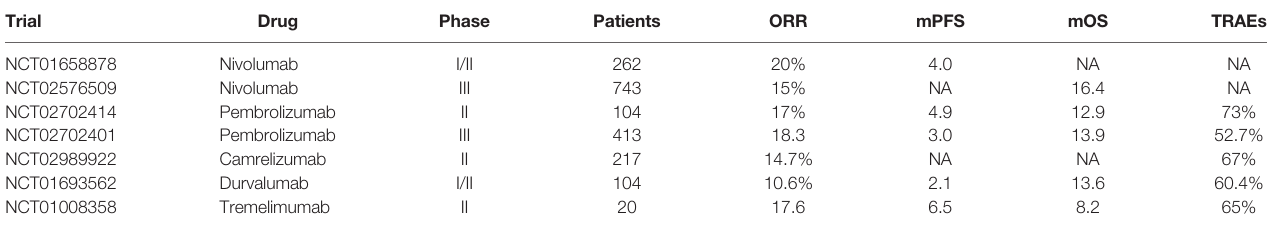
TABLE 1 | Clinical trials of monotherapy of immune checkpoint inhibitors for advanced HCC.